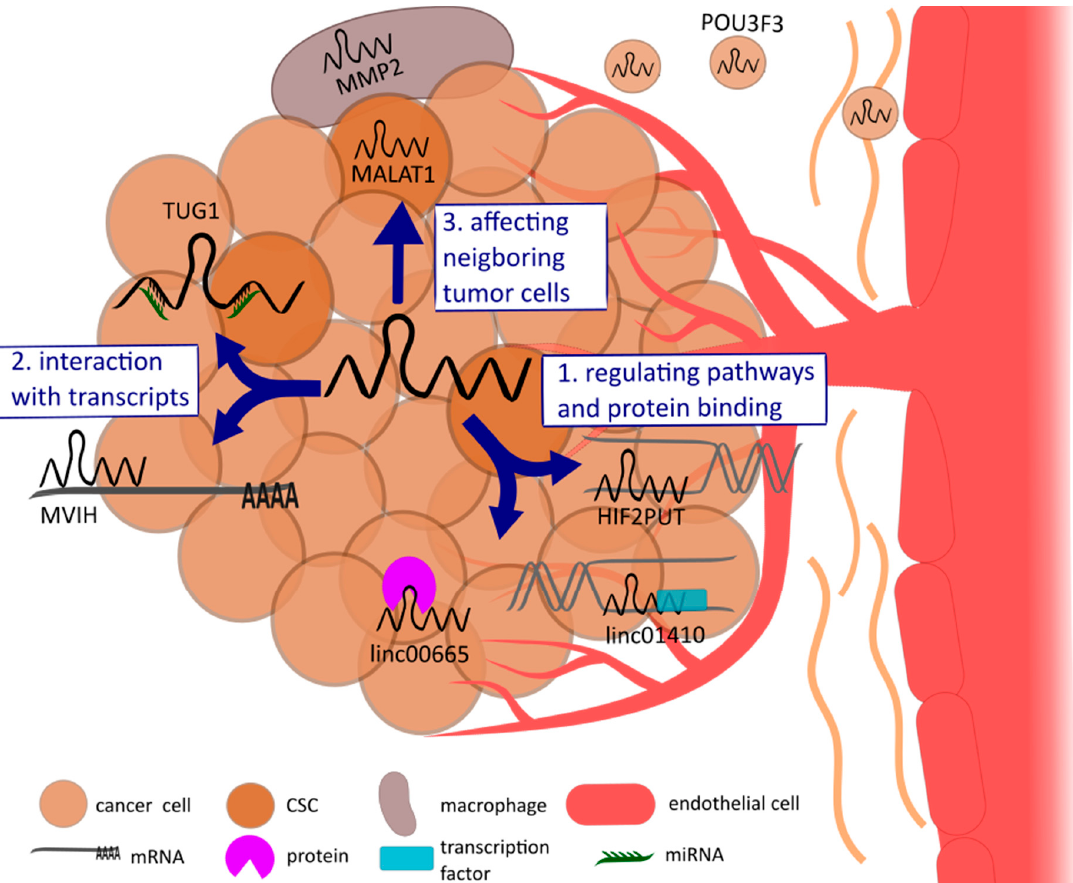
Figure 3. Schematic representation of the regulating mechanisms of lncRNAs influencing tumor angiogenesis: (1) protein binding and regulating pathways indirectly by recruiting transcription factors or directly affecting oncogenic pathways, (2) interacting with transcripts such as mRNA or miRNA, and (3) regulating neighboring cells, including the tumor microenvironment cells, e.g., cancer stem cells (CSC), macrophages, and endothelial cells. The latter mechanism is possible due to exosomal transport of lncRNAs. Exemplary lncRNAs for each shown mechanism are named in the figure.